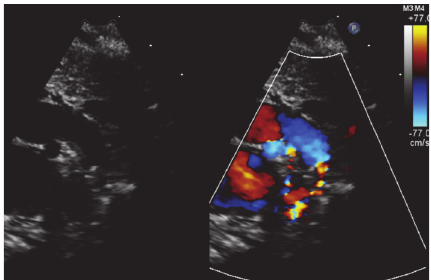
Figure 2: Echocardiogram demonstrating juxtaductal coarctation of the aorta following patent ductus arteriosus ligation